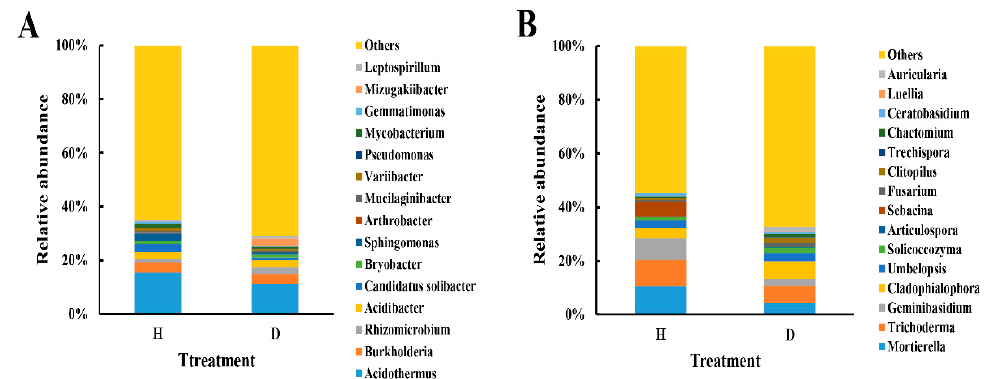
Figure 3. Relative abundance of bacteria ( A ) and fungi ( B ) at the genus level. H and D represent healthy and diseased trees, respectively.